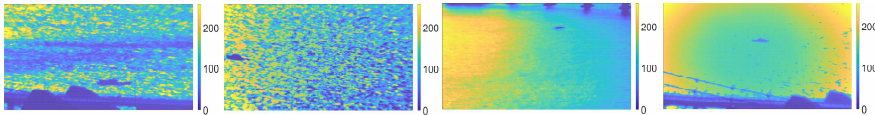
Figure 4. Infrared thermal image of maritime target in backlight environment.